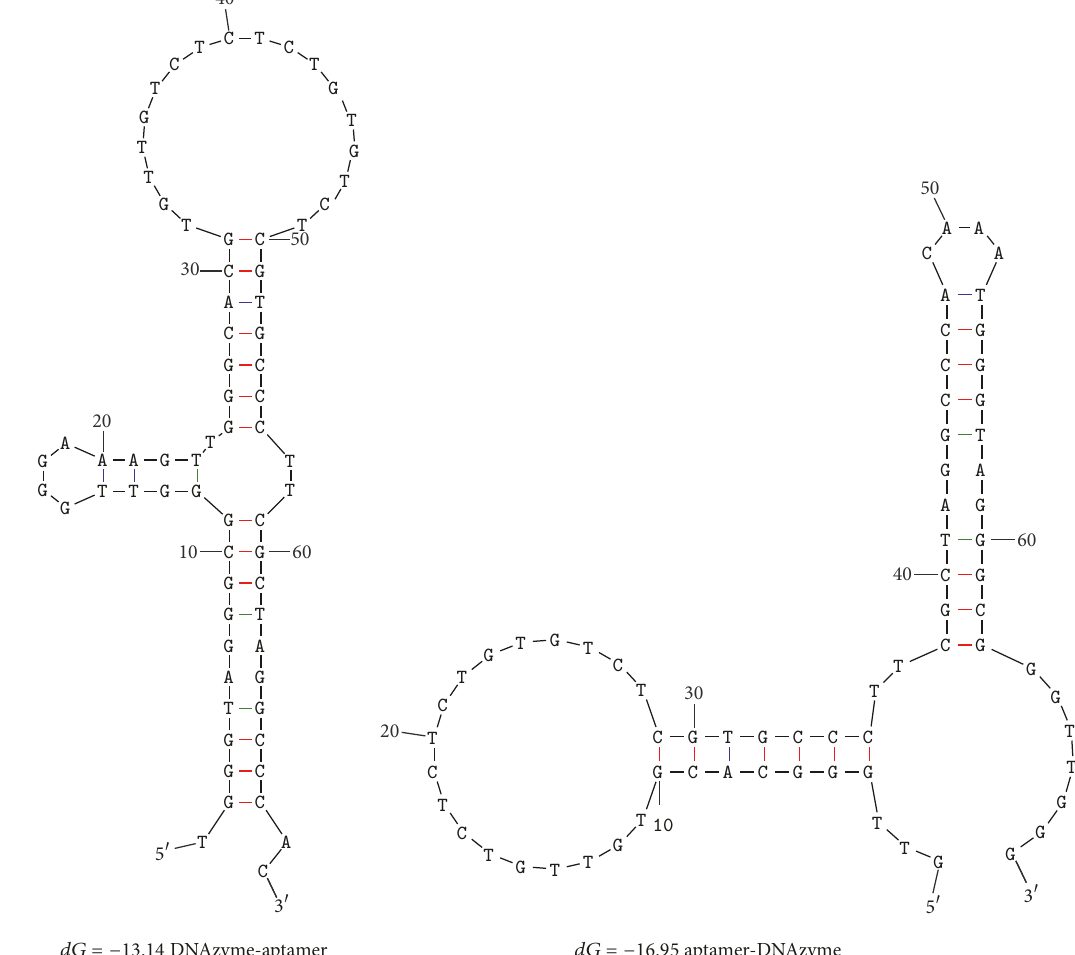
Figure 1: Predicted secondary structure of DNAzyme-aptamer and aptamer-DNAzyme using Mfold tool.